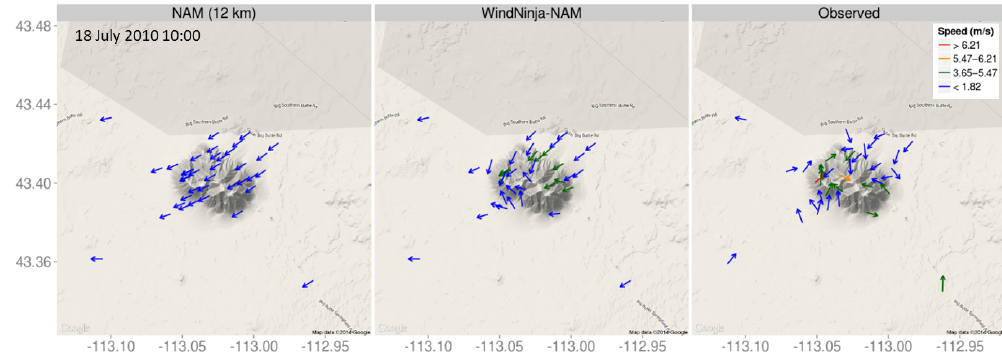
Figure 8. Predicted and observed winds for an upslope flow event at Big Southern